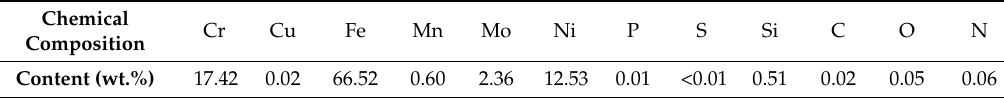
Table 1. The chemical composition of the 316L stainless steel powder.